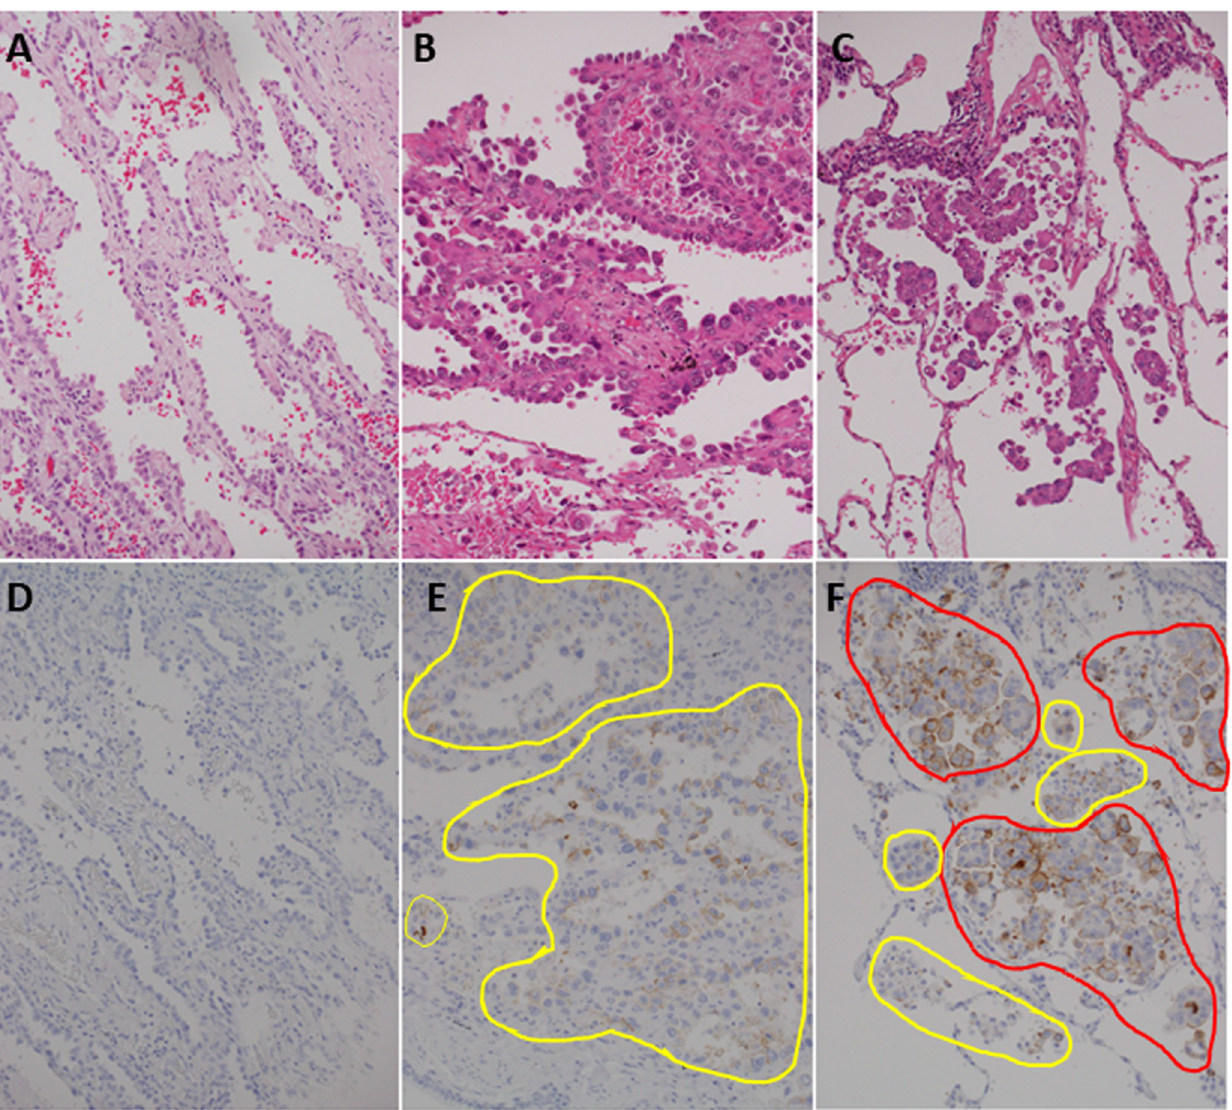
Fig 1. Representative images of tumors with varying immunohistochemical scores. Tumor cells with weak signal (intensity 1) are in the yellow circle, and tumor cells with strong signal (intensity 2) are in the red circle. In the left panels, positive signal is not detected throughout the tumor (Score 0) (A and D). In the center panels, weak signal is detected in most (90%) neoplastic cells (score 90 = 1 × 90) (B and E). In the right panels, strong signal is detected in most (80%) neoplastic cells (score 180 = 1 × 20 + 2 × 80) (C and F). A, B, and C are the hematoxylin and eosin stain. D, E, and F are immunohistochemistry for MUC21 with the polyclonal antibody. Magnification of all images is 200 ×